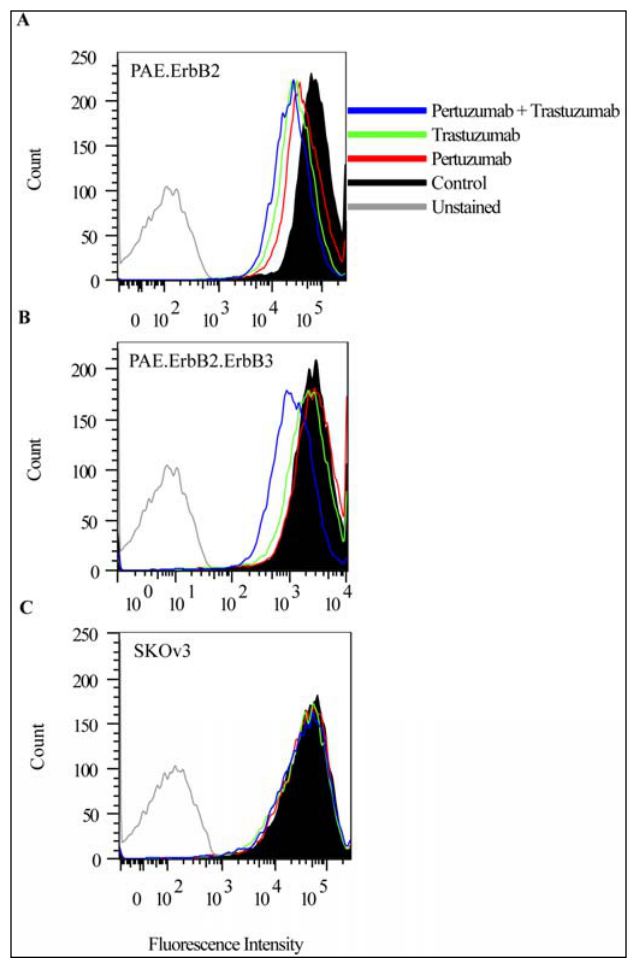
Figure 2. Pertuzumab and trastuzumab have an additive effect on down-regulation of ErbB2 from the plasma membrane in cells expressing ErbB2 and ErbB3 only. PAE.ErbB2 ( A ), PAE.ErbB2.ErbB3 ( B ) and SKOv3 ( C ) cells were incubated without antibodies (Control), or with pertuzumab (25 µg/mL), trastuzumab (21 µg/mL), or pertuzumab and trastuzumab for 24 h at 37 °C. The cells were fixed and immunostained using mouse anti-ErbB2 antibody followed by APC-conjugated goat anti-mouse antibody before the amount of ErbB2 at the plasma membrane was measured by flow